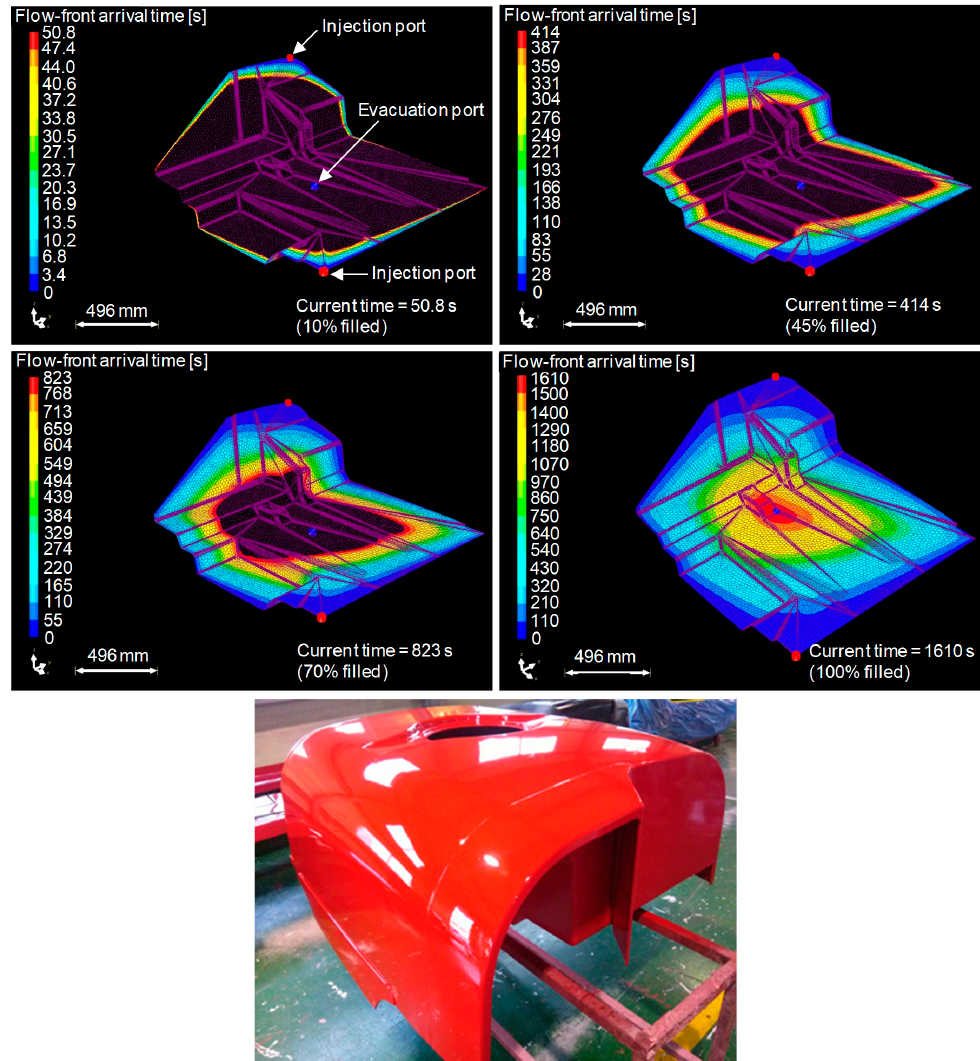
Figure 9. Resin flow simulation conducted in RTM-Worx software for the vacuum-assisted, light-RTM manufacture of the lower part of a flax–vinylester composite agricultural chemical storage tank. Images show progression of the flow front at time intervals as the part is 10%, 45%, 70% and 100% filled, with an image of the final fabricated component. Adapted from [64], with permission from © 2014 Prof. C Kong.